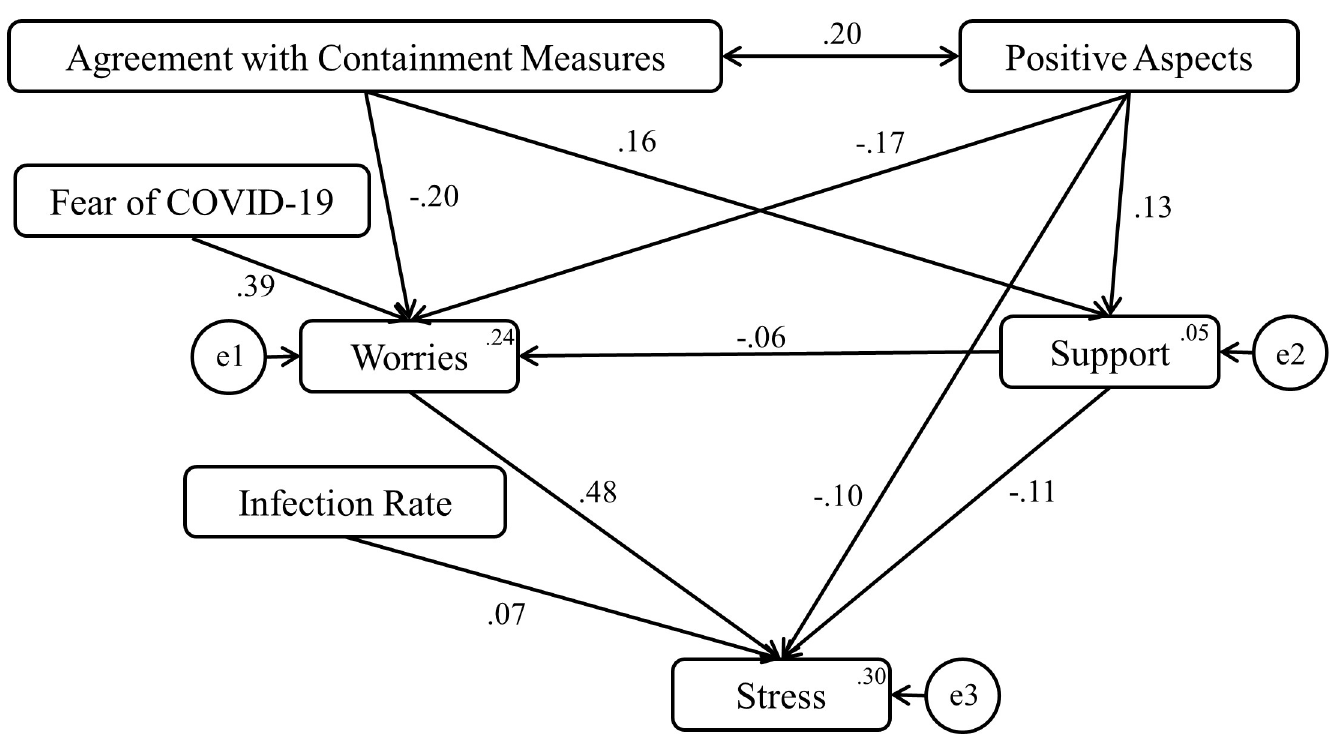
Fig 1. A path model showing the influence of various determinants on stress. Model fit statistics: χ 2 (10) = 42.85, p < .01, GFI = .99, CFI = .97, NFI = .96, TLI = .94, RMSEA = .05. All path coefficients turned out to be highly significant (all paths p < .001, except path between Support and Worries: p < .005). Error variances appear in small